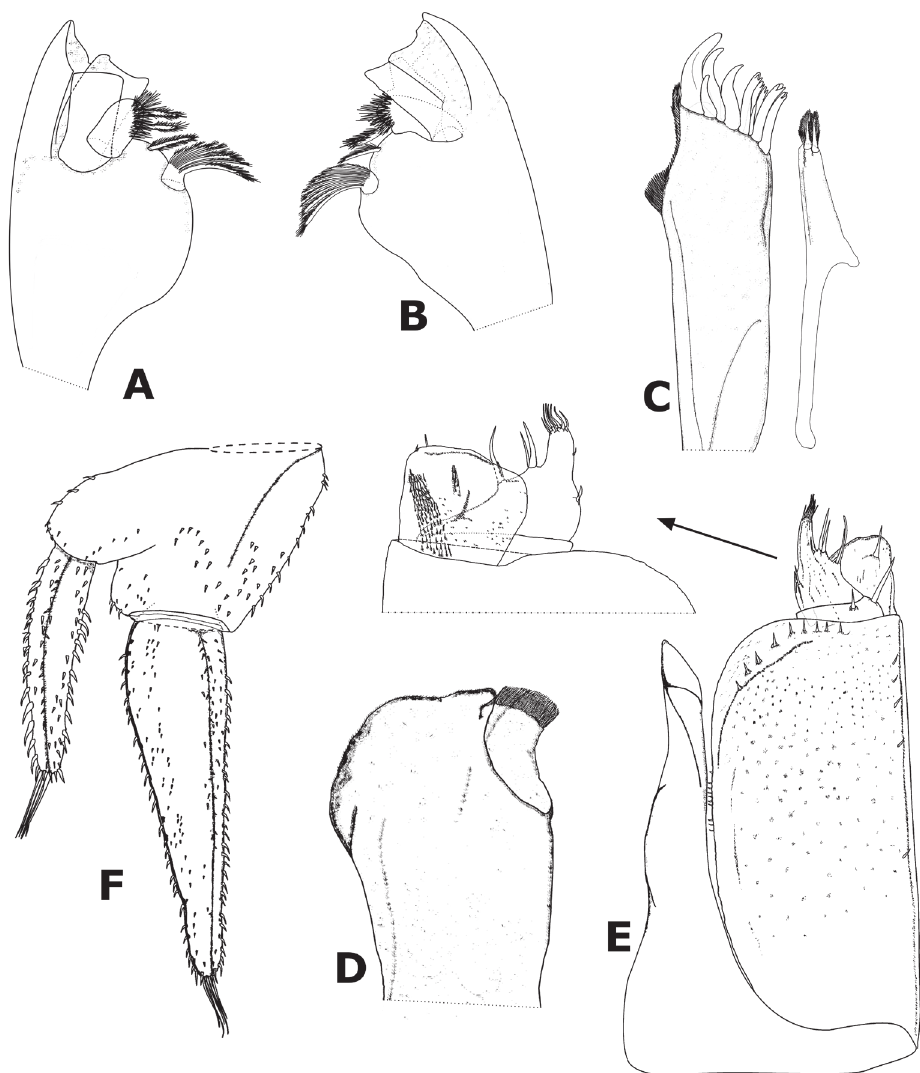
Figure 3. Pulmoniscus turbanaensis n. sp. ♀ Paratype (CUDC-CRU 14): A. Left mandible; B. Right mandible; C. Maxillula; D. Maxilla; E. Maxilliped; F.